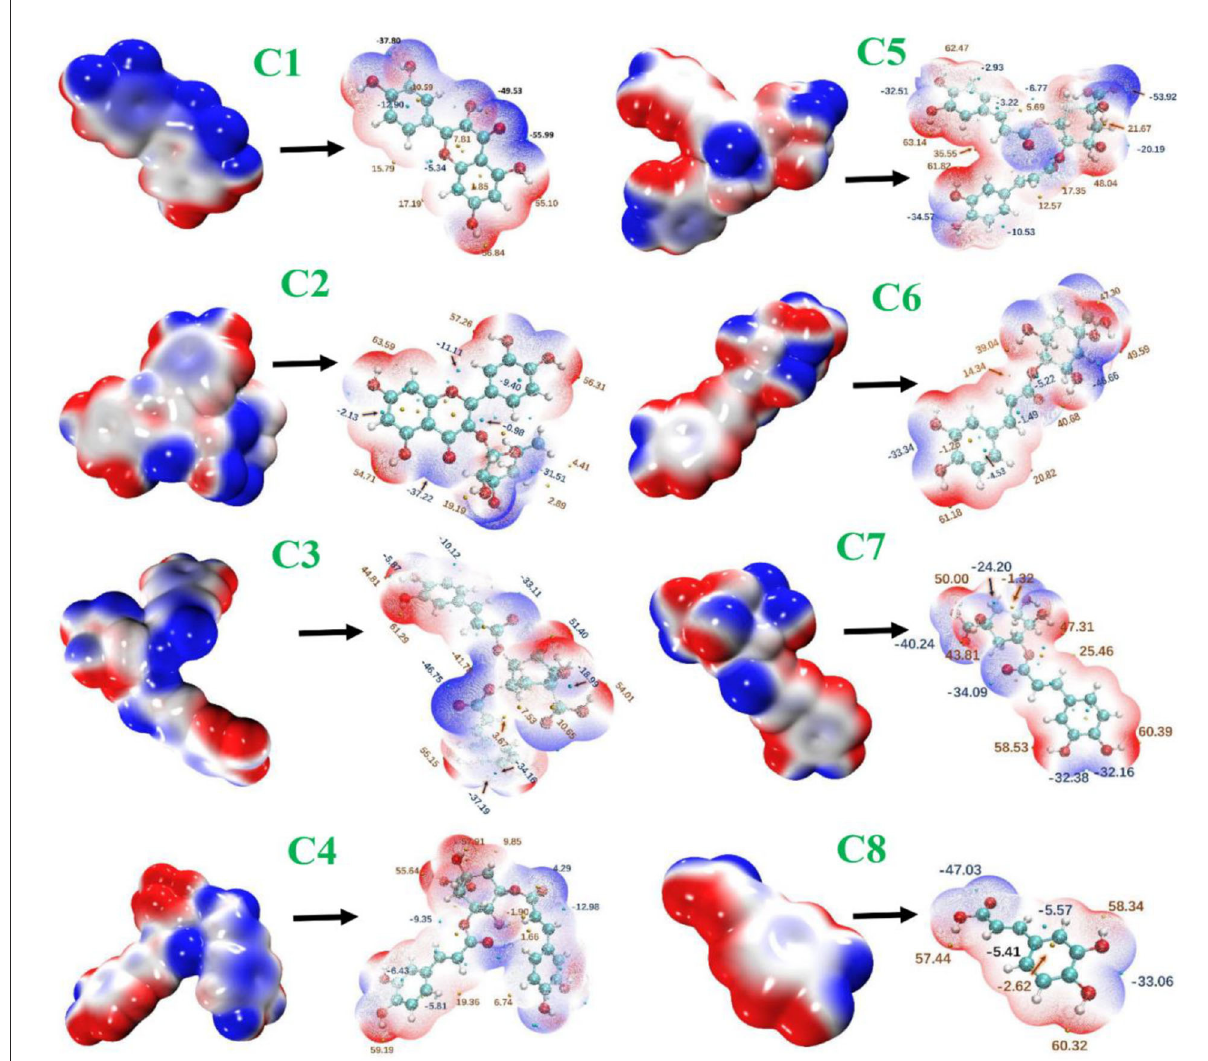
FIGURE10 Electrostatic potential surfaces mapped molecular vdW surface of phenolic compounds. The transparent ones correspond to the extrema at the backside of a graph. C1, quercetin; C2, quercetin-3-rhamnoside; C3, 4,5-O-dicaffeoylquinic acid; C4, 3,5-O-dicaffeoylquinic acid; C5, 3,4-O-di-caffeoylquinic acid; C6, 4-O-caffeoylquinic acid; C7, 3-O-caffeoylquinic acid; and C8, caffeic